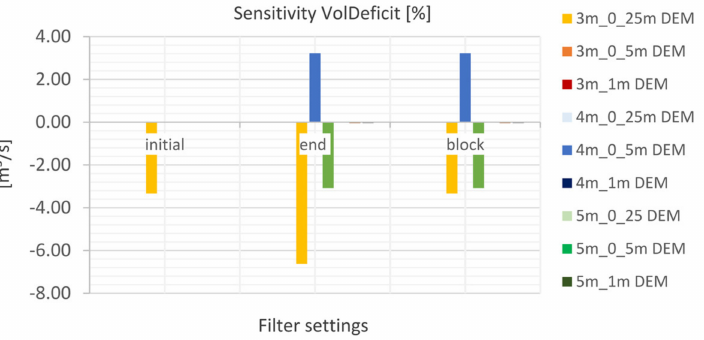
Figure 37. Comparison of the model sensitivity (S-VD) for the precipitation distribution and the evaluated mesh and DEM